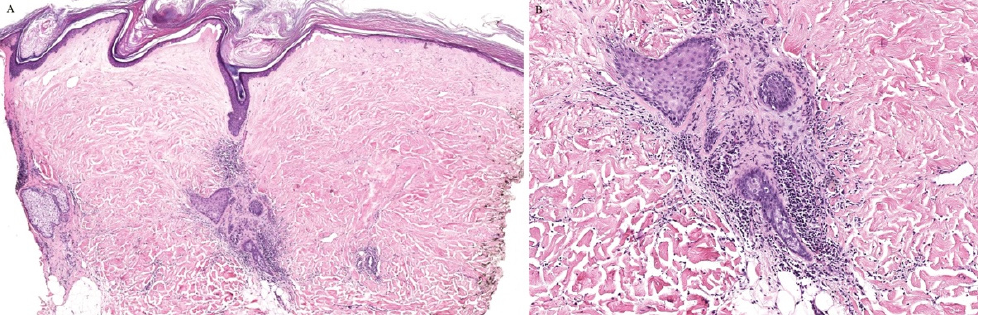
Figure 4. ( A , B ) Lichen sclerosus with perifollicular inflammation.